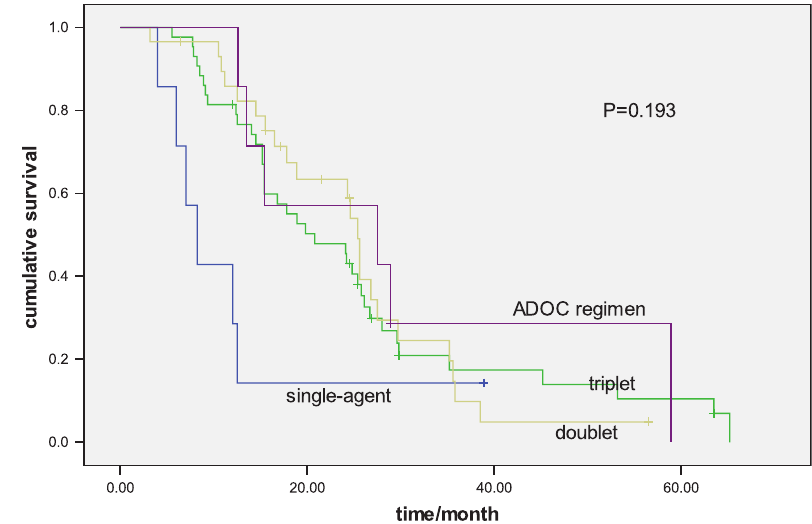
Figure 1 - Kaplan–Meier curves comparing PFS in patients treated with various first-line chemotherapy